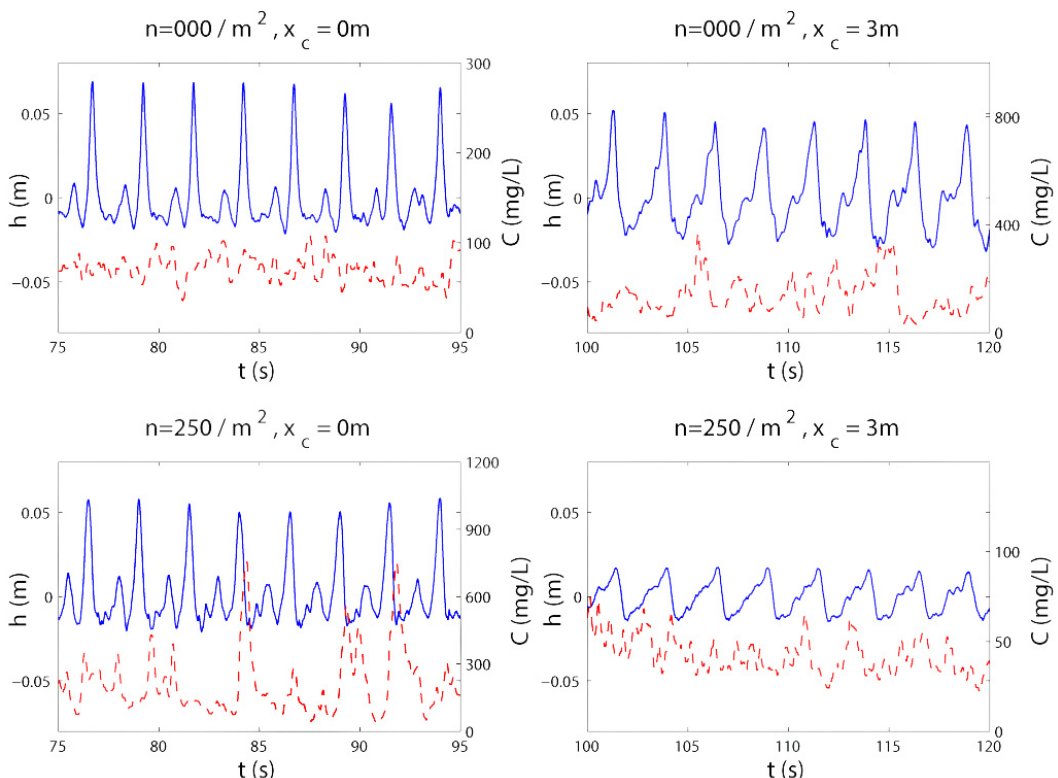
Figure 13. Time series of free surface elevation (blue solid line) and concentration (red dashed line) for the non-populated (up) and densest (down) cases, at locations x c = 0m (left) and x c = 3m (right), for waves H = 0 . 05m. Notice the scale for η is conserved in all figures, while the scale of C changes between figures.